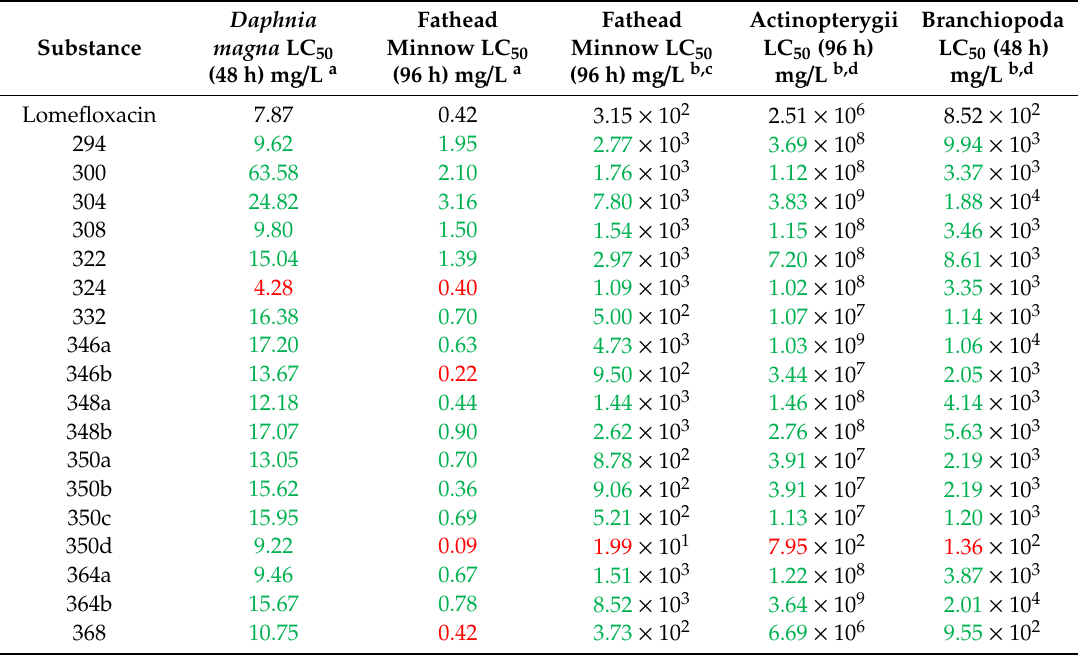
Table 6. QSAR analysis of the phototransformation products of LOM with less (green) and more hazardous (red) photoproducts as compared to the parent compound. The photoproducts are indicated by their m / z values. The activities against the organisms are given as concentration.